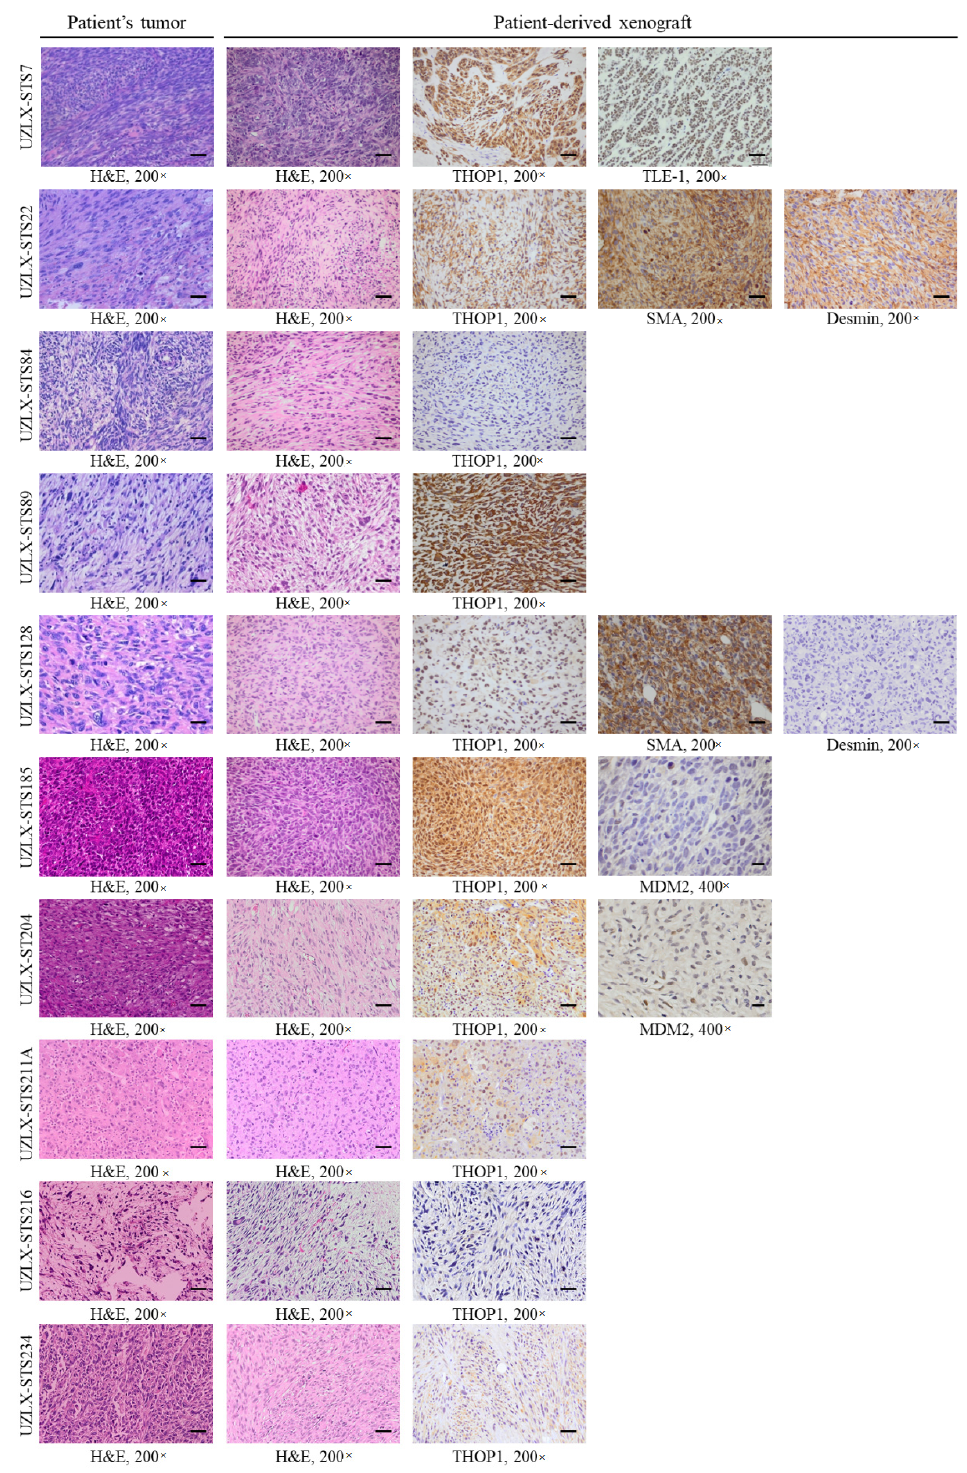
Figure 1. Characterization of the patient-derived sarcoma xenograft models used in this study. Representative H&E and immunostainings of the original patient tumors and the corresponding patient-derived xenografts; scale bar 200 × : 50 µ m, scale bar 400 × : 20 µ m. Alpha-SMA: alpha smooth muscle actin; H&E: hematoxylin and eosin; MDM2: mouse double minute 2 homolog; THOP1: thimet oligopeptidase; TLE-1: transducin-like enhancer of split 1; 200 × : 200-fold magnification; 400 × : 400-fold